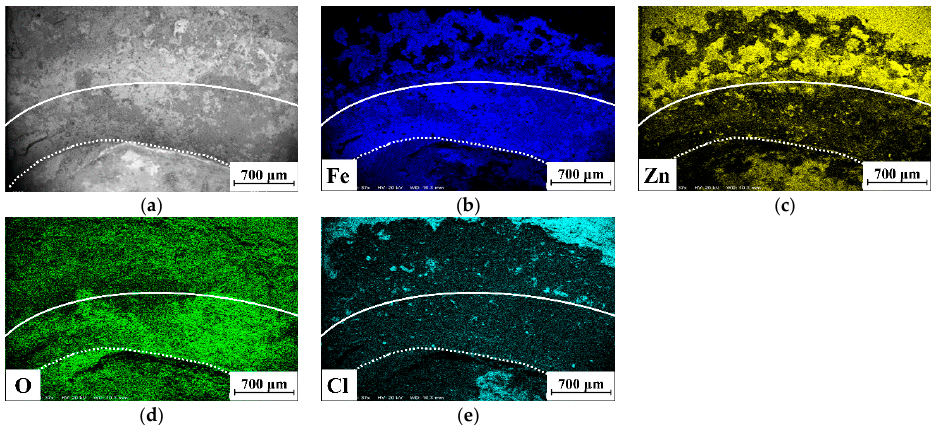
Figure 10. ( a ) SEM micrograph (BSE mode) on weld spot surface and surrounding HAZ of sample no. 2 after the salt spray exposure test. Chemical distribution of elements ( b ) Fe, ( c ) Zn, ( d ) O, and ( e ) Cl, as obtained from EDS analysis. White dotted lines point out the border of the fractured spot weld on the sheet (top line) and on the pull out head (bottom line). The continuous line defines the border of the sheet surface without the zinc layer.